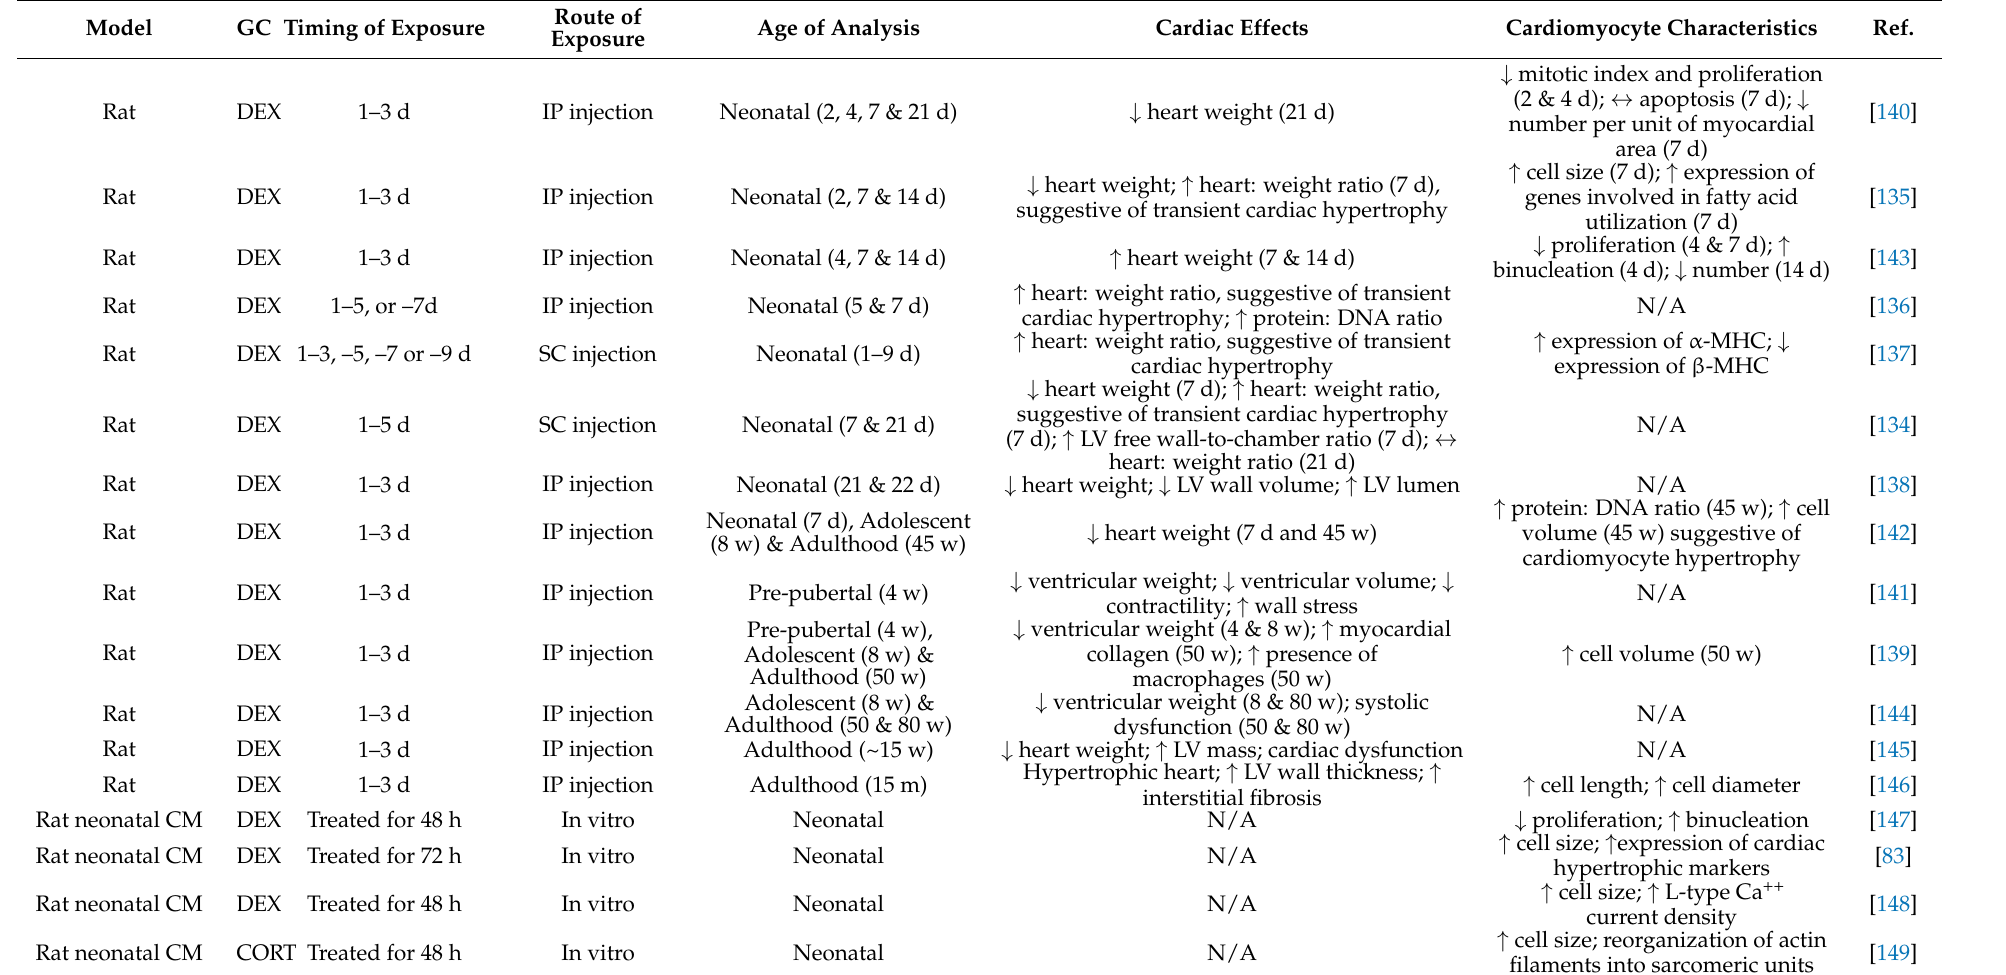
Table 2. Effects of postnatal glucocorticoid administration on the